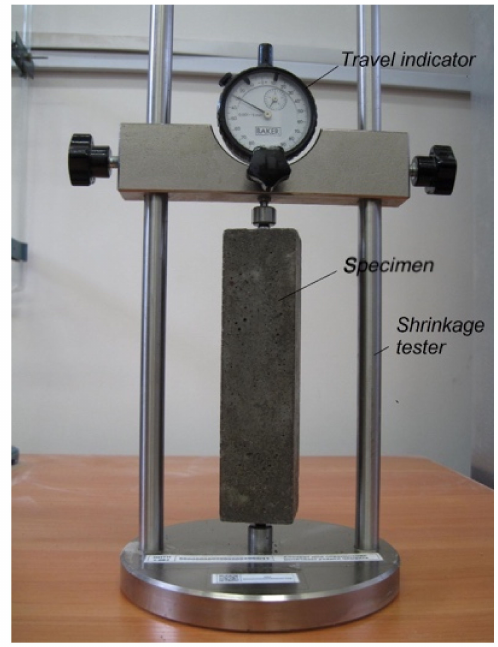
Figure 3. Device for measuring shrinkage of concrete